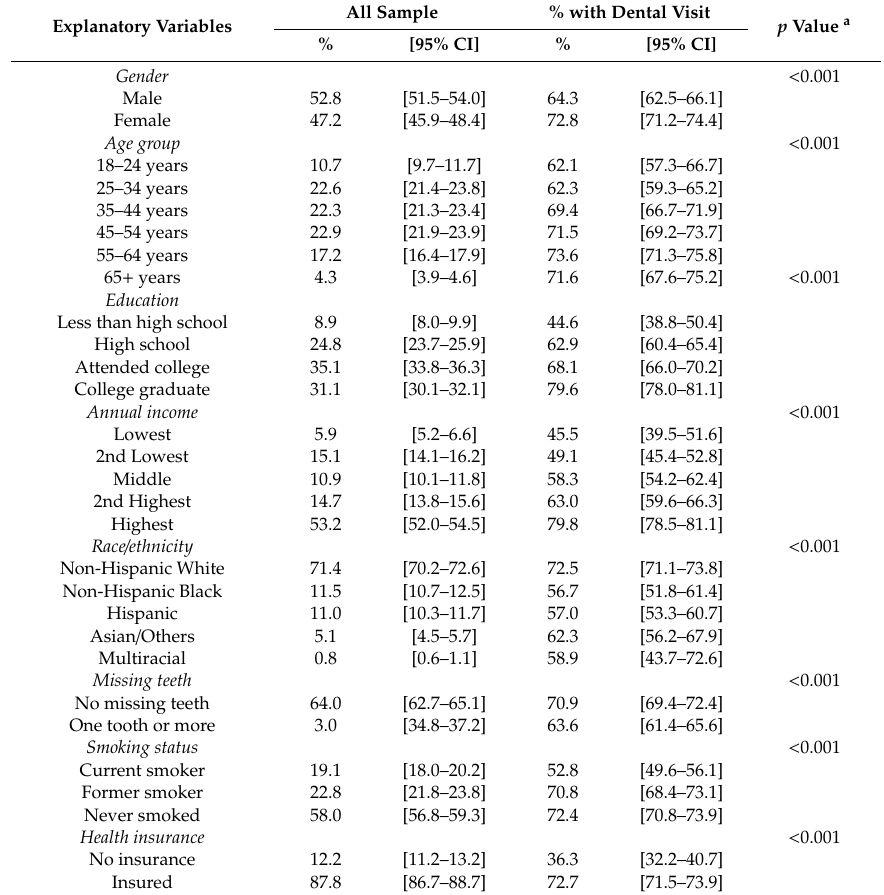
Table 1. Characteristics of the sample and proportion of participants who visited the dentist in the past year by covariates ( n = 11,950). All Explanatory Variables